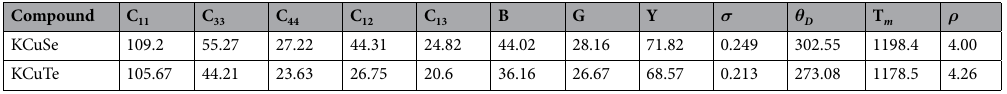
Table 2. Elastic constants, bulk (B), shear (G) and youngs modulii (Y) (GPa), Poissons ratio ( σ ),